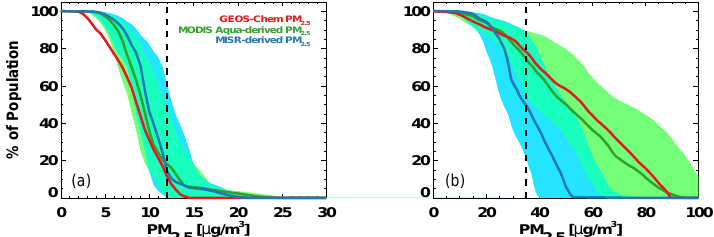
Figure 5. Percent of the population exposed to different annual PM 2 . 5 concentrations in the US (a) and China (b) . Lines denote estimates using the unconstrained GEOS-Chem simulation (red) or using satellite-based estimates with MODIS (green) and MISR (blue). Shading represents potential uncertainty associated with the model η (described in Sect. 4.2) and dashed black lines represent national annual air quality